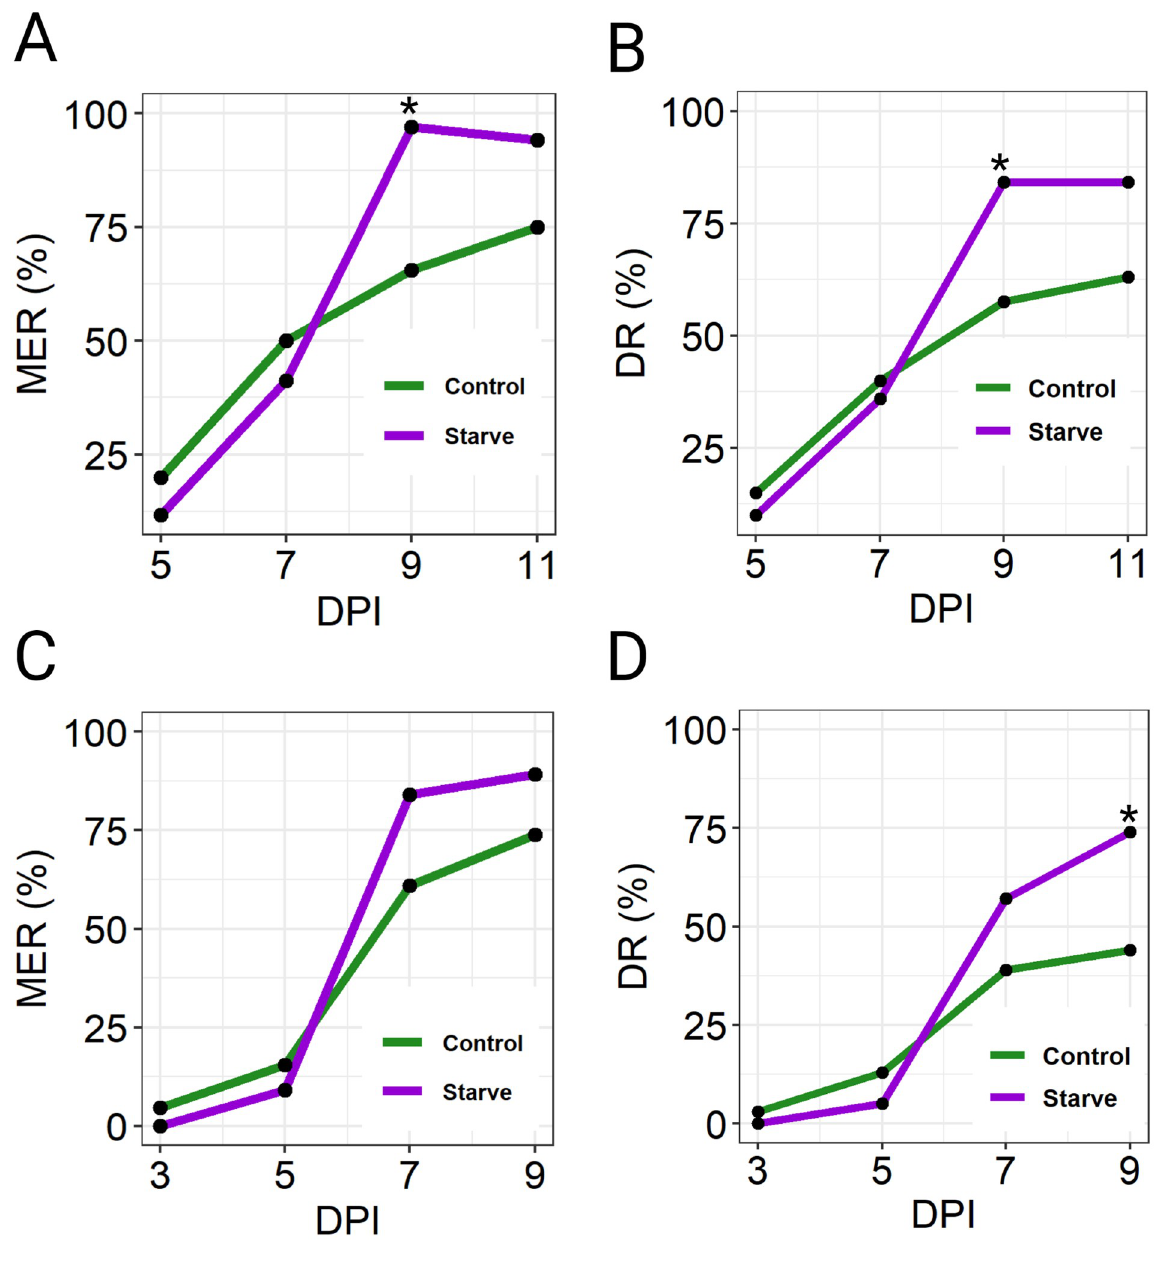
Fig 4. ZIKV I-44 midgut escape and dissemination rates in Control and Starve Ae . aegypti HWE following oral ingestion of virus in two independent experiments. The ZIKV titre in the blood-meal was 1.7x10 6 plaque forming units (PFU) per mL. Virus was quantified in individual midguts and carcasses (n = 20–39 per group/timepoint) by plaque assay on Vero cells at 5, 7, 8, 9, and 11 days post-infection (dpi) in the initial experiment ( A , B ) and at 3, 5, 7 and 9 dpi in the second experiment ( C , D ). ( A , C ) ZIKV midgut escape rates (MER) for Starve and Control mosquitoes in experiment 1 ( A ) and experiment 2 ( C ), defined as the number of virus-positive carcasses divided by the number of virus-positive midguts over the time-course. ( B , D ) ZIKV dissemination rates (DR) for Starve and Control mosquitoes in experiment 1 ( B ) and experiment 2 ( D ), defined as the number of virus-positive carcasses divided by the total number of carcasses analysed. Count data (infected/non-infected tissues) were used for statistical analysis by Fisher’s Exact test; � = p < 0.05.